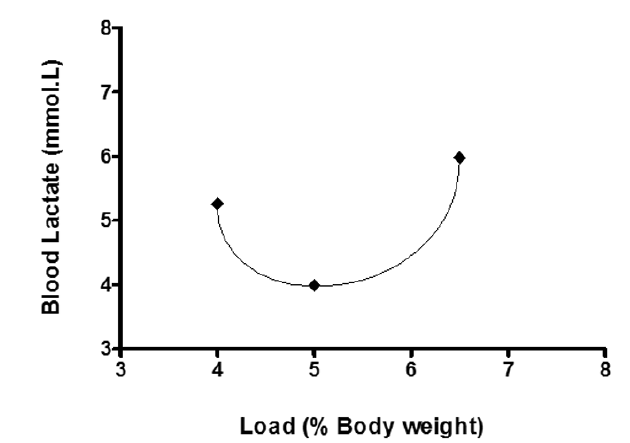
Figure 3. Blood lactate concentration curve versus workload of one rat (T group) during the post-training LACmin 1.0387 x 2 – 10.618 x + 31.113 enabled the calculation of the BLM con- centration and its workload (% bw).